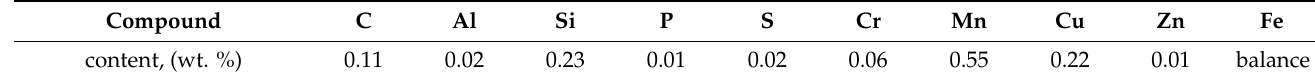
Table 6. Composition of plain bar steel 10216 (GD-OES). Compound C Al Si P S Cr Mn Cu Zn Fe content, (wt. %) 0.11 0.02 0.23 0.01 0.02 0.06 0.55 0.22 0.01